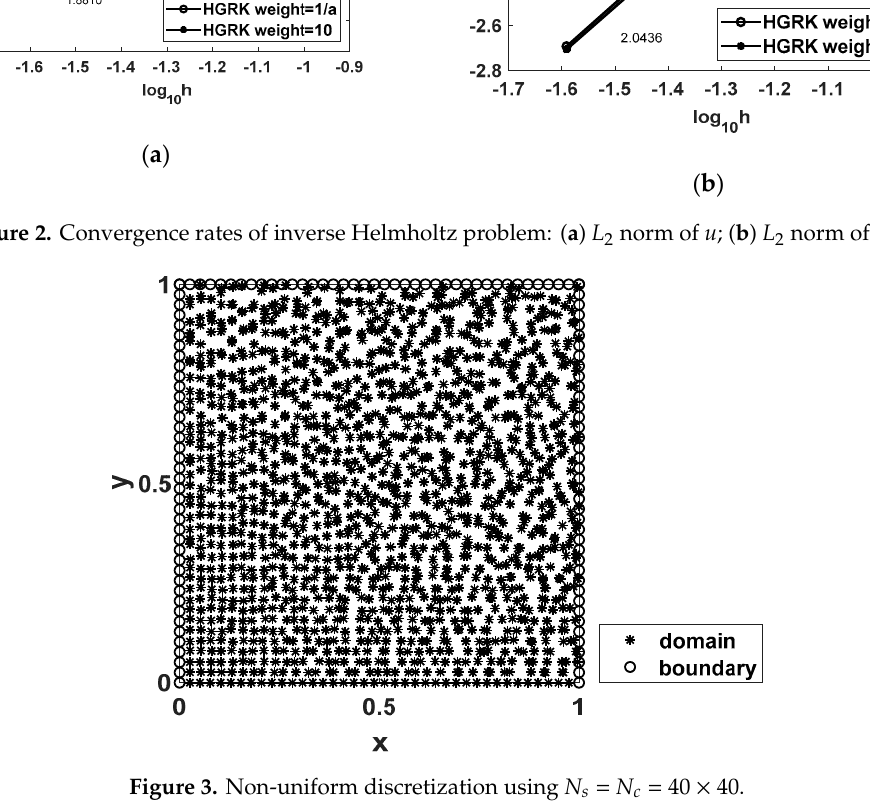
( b ) Figure 4. Contour plot of absolute error (%): ( a ) uniform discretization; ( b ) non-uniform discretization.